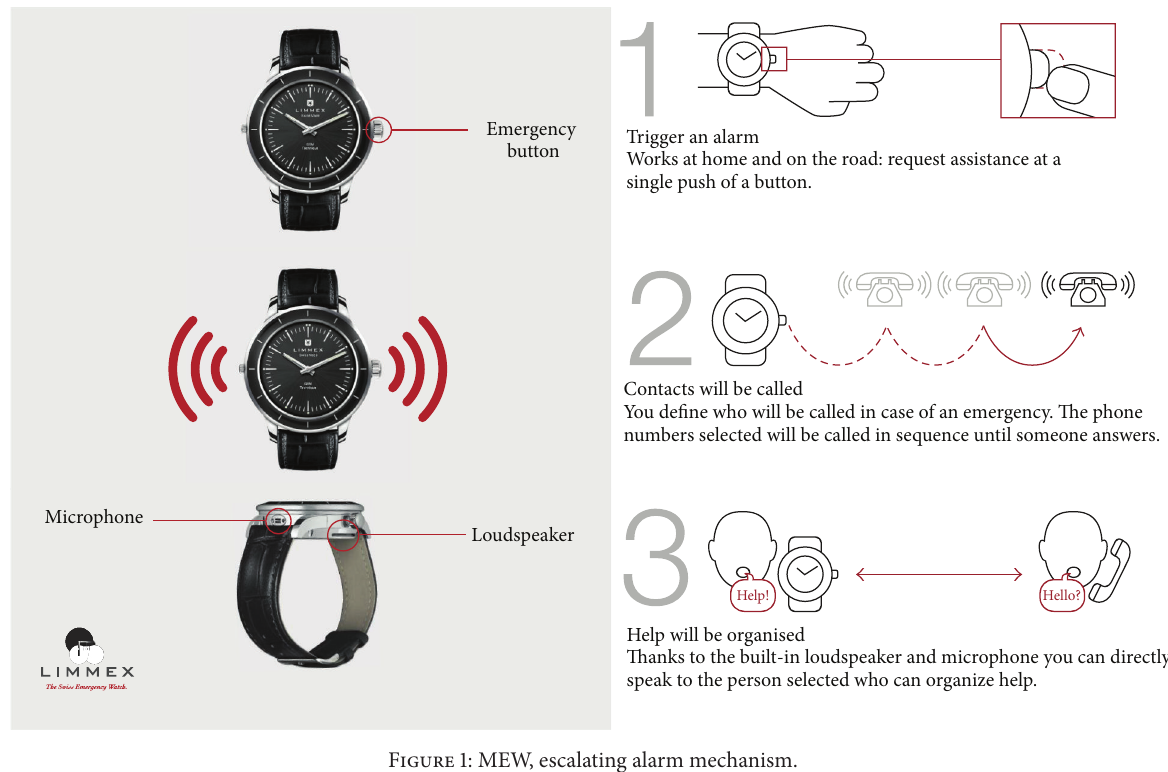
Figure 1: MEW, escalating alarm mechanism.